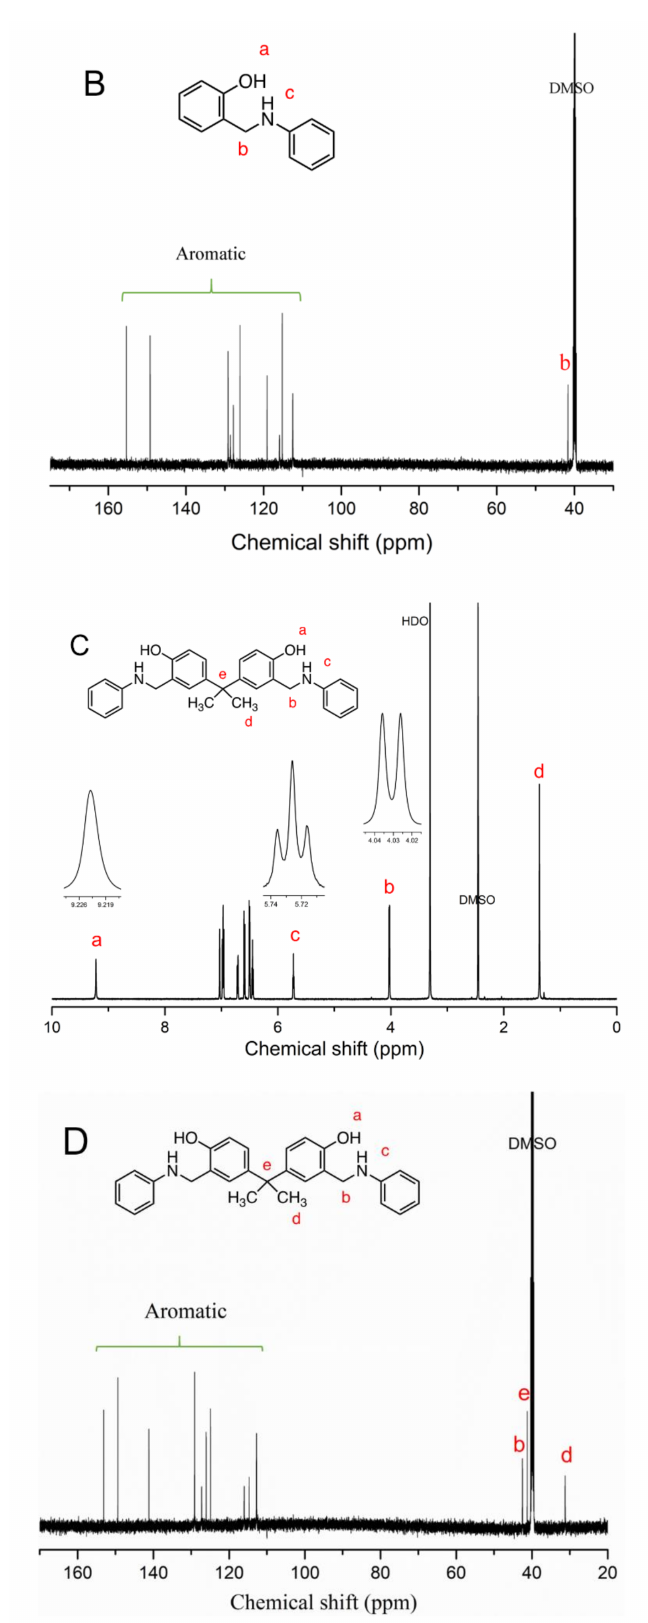
Figure 1. 1 H and 13 C nuclear magnetic resonance (NMR) spectra of h PH-a ( A , B ) and h BA-a ( C , D ) in DMSO-d